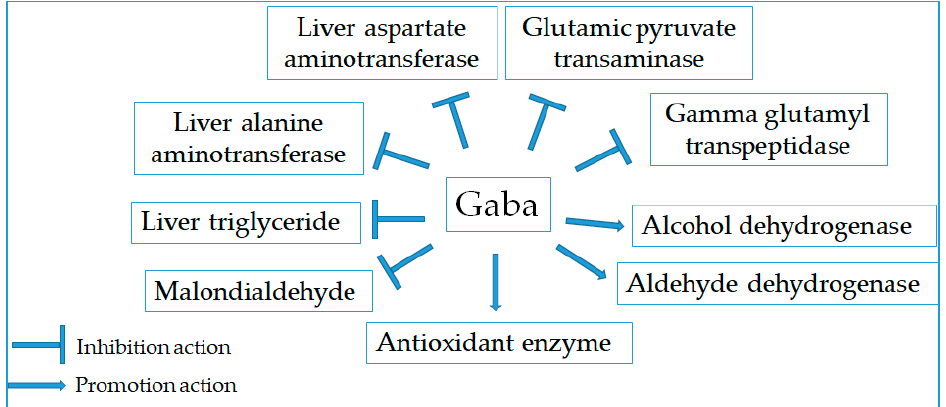
Figure 7. Mechanism of the action of Gaba for hepatoprotection.